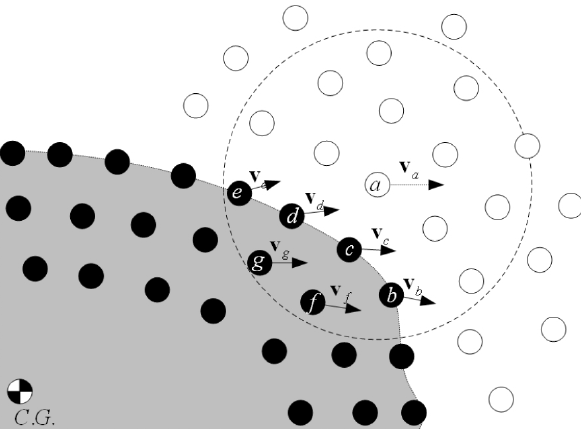
Figure 19. Coupling of the fluid and solid phases. BCE and fluid markers are represented by black and white circles, respectively.